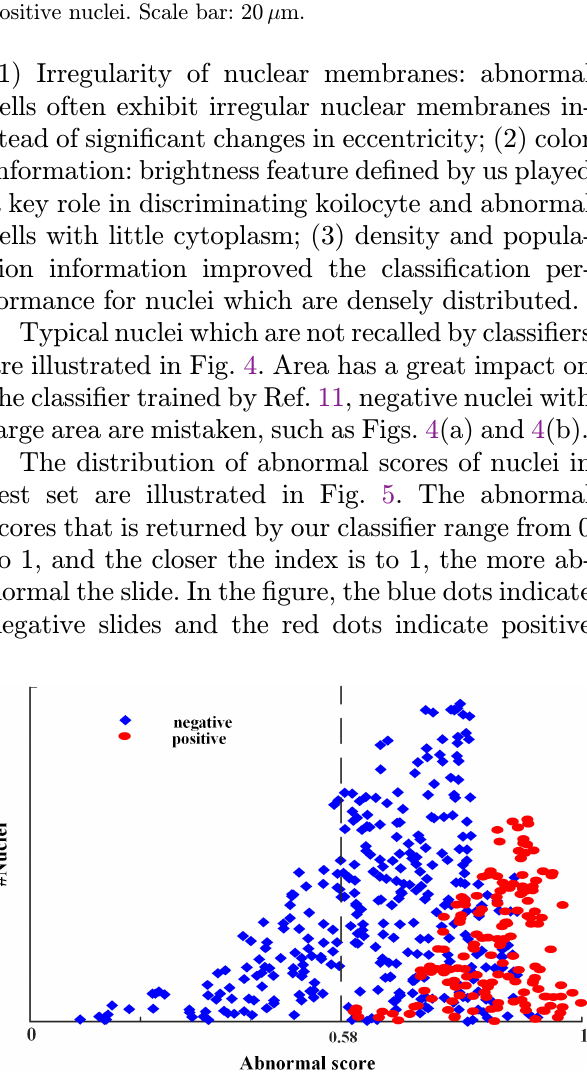
Fig. 5. Distribution of abnormal score of nuclei in test